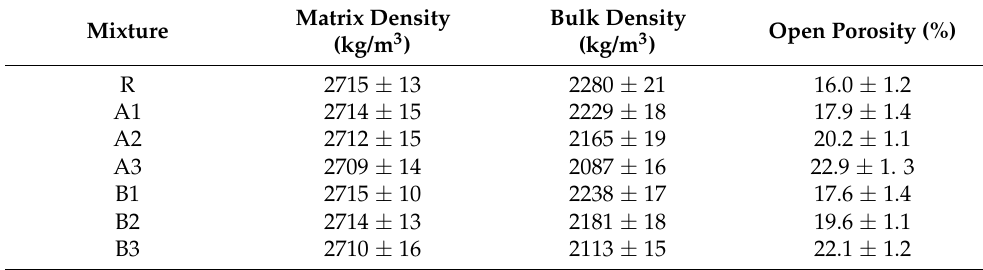
Table 3. Basic material properties of designed cement mortars at 28 days.